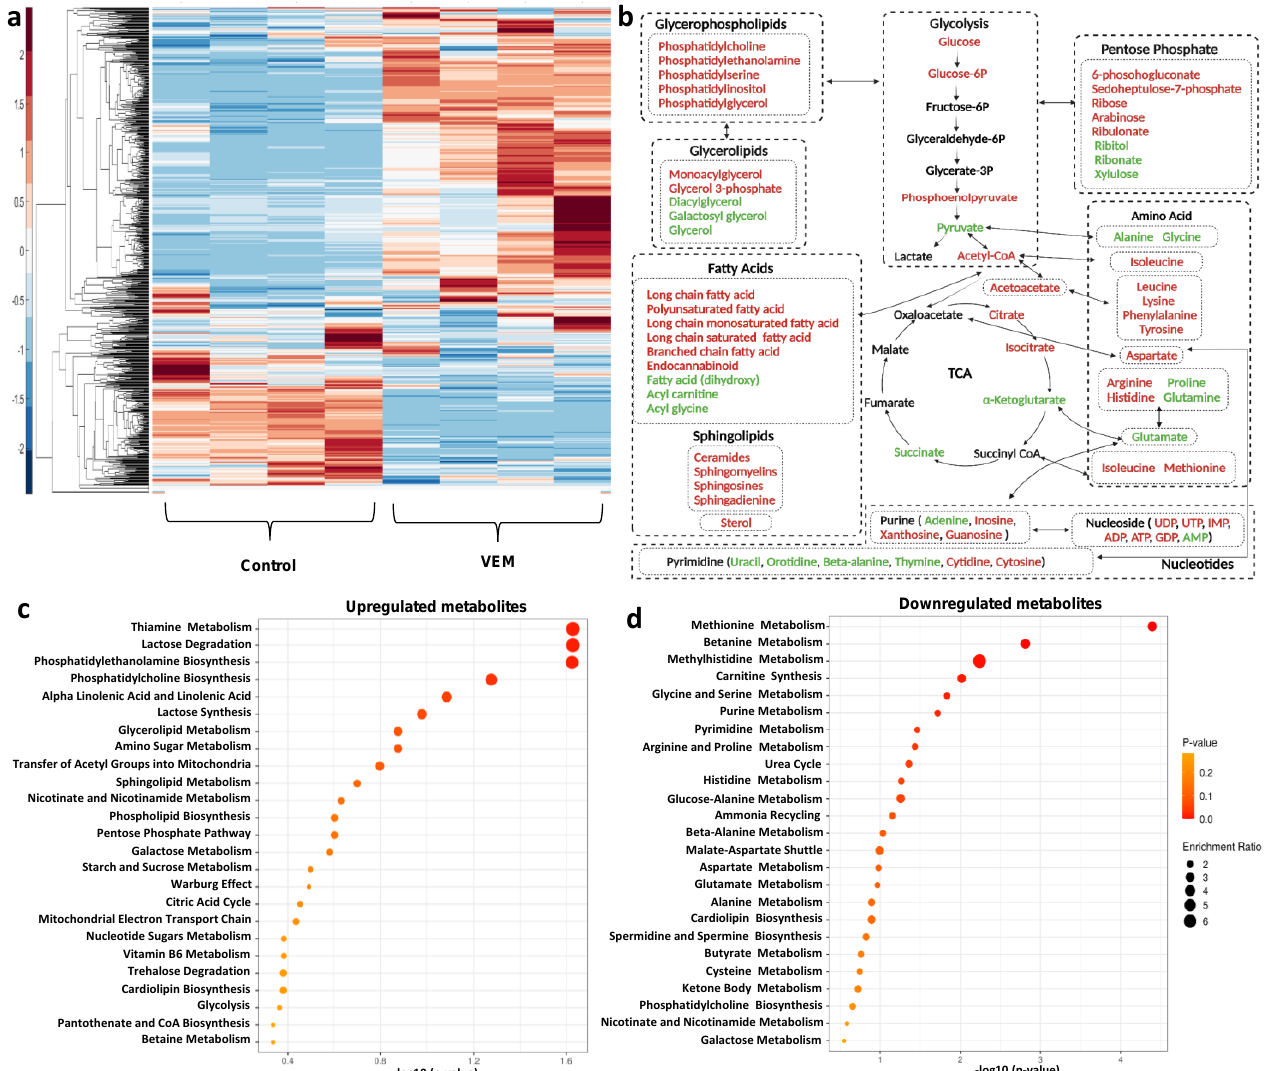
Figure 3. Metabolic profiles of VEM-induced persister cells. ( a ) VEM-treated and untreated A375 cells were collected for mass spectrometry analysis to measure their metabolite contents. The data generated with metabolomics were clustered (un- supervised) using the Clustergram function in MATLAB. Each column represents a biological replicate; each row represents a metabolite. n = 4. ( b ) A simplified metabolic network of persister cells (created with Biorender). Red and blue represent upregulated and downregulated metabolites in persisters when compared to the control group, respectively (ANOVA, p < 0.05). ( c , d ) Pathway enrichment analysis for all upregulated and downregulated metabolites with MetaboAnalyst,